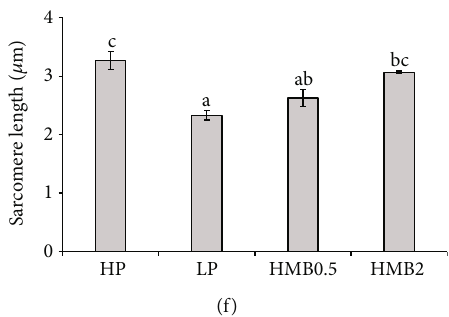
Figure 3: The morphology of myo fi ber in kuruma shrimp fed with the experimental diets. (a) Myo fi ber microstructure of cross sections. Magni fi cation 200 × . (b) Myo fi ber microstructure of longitudinal sections. Magni fi cation 400 × . (c) Myo fi ber density and diameter of kuruma shrimp. (d) Transmission electron micrographs of cross sections. (e) Transmission electron micrographs of longitudinal sections. (f) Myo fi brillar sarcomere length of kuruma shrimp. A and B represent myo fi brillar structure in the HP group taken at a magni fi cation of 3000 × and 5000 × , respectively. C and D represent myo fi brillar structure in the LP group taken at a magni fi cation of 3000 × and 5000 × , respectively. E and F represent myo fi brillar structure in the HMB0.5 group taken at a magni fi cation of 3000 × and 5000 × , respectively. G and H represent myo fi brillar structure in the HMB2 group taken at a magni fi cation of 3000 × and 5000 × , respectively. MF: myo fi ber; FD: myo fi ber diameter; mf: myo fi bril; MT: mitochondrion; SPR: sarcoplasmic